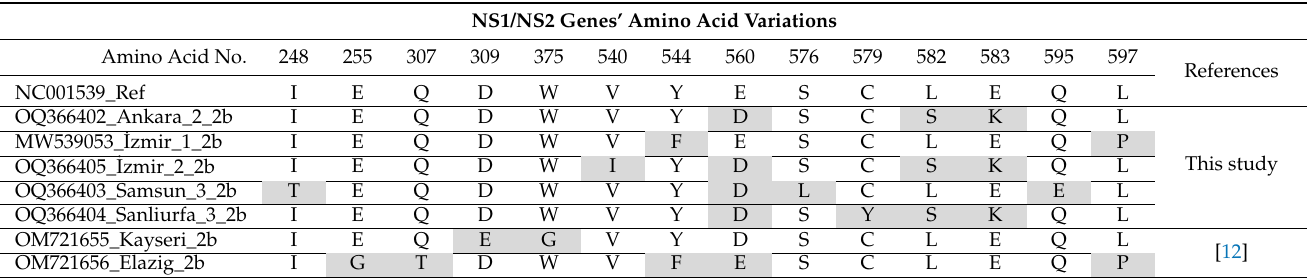
Table 3. NS1/NS2 genes’ amino acid variations.